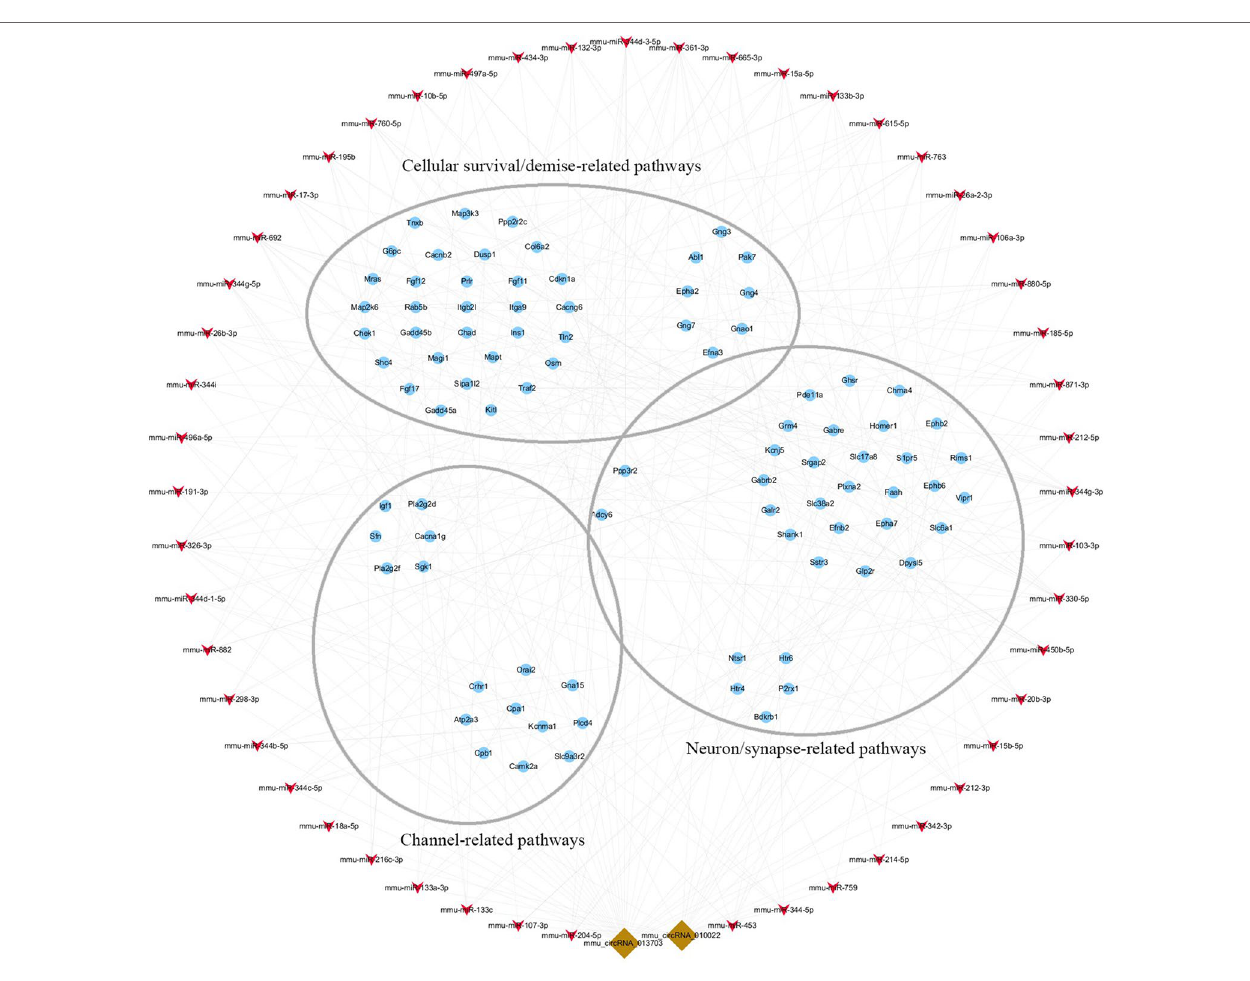
FIGURE 10 | The key function module of circRNA-miRNA-mRNA network. The network was drawn based on the biological function of circRNA co-expression genes. Nodes in red are miRNAs, nodes in light-blue are mRNAs, and nodes in brown are circRNAs. The interconnected nodes represent direct